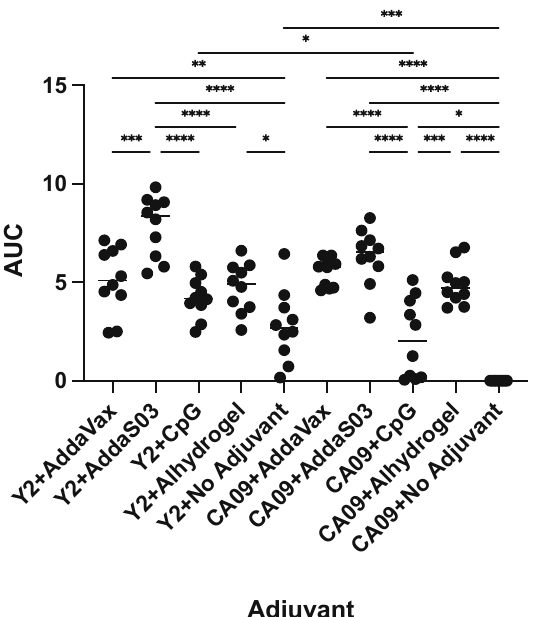
Figure 3. cH6/1 HA IgG titers at d56 after adjuvanted vaccination with Y2 and CA09 HAs. Serum IgG titers, determined by ELISA, are shown as AUC values for both Y2- and CA09 HA-immunized mouse groups. A minimum baseline absorbance at 405 nm of 0.3 was considered a positive binding signal. *, p ≤ 0.05; **, p ≤ 0.01; ***, p ≤ 0.001; ****, p ≤ 0.0001. One-way ANOVA was used for statistical comparisons between groups.